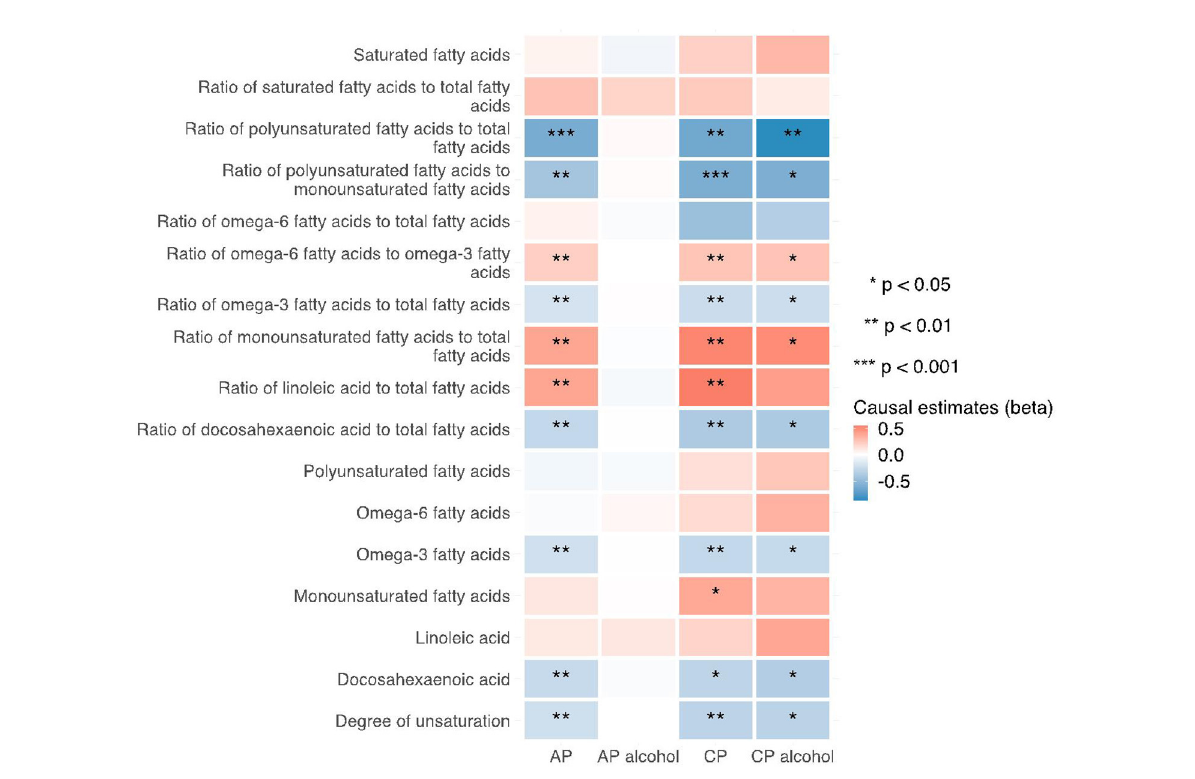
FIGURE6 Heatmap showing the weighted median causal estimates of traits related with fatty acid (un)saturation in met-d on pancreatitis using two-sample MR. AP, acute pancreatitis; CP, chronic pancreatitis; IVW, inverse-variance weighted.